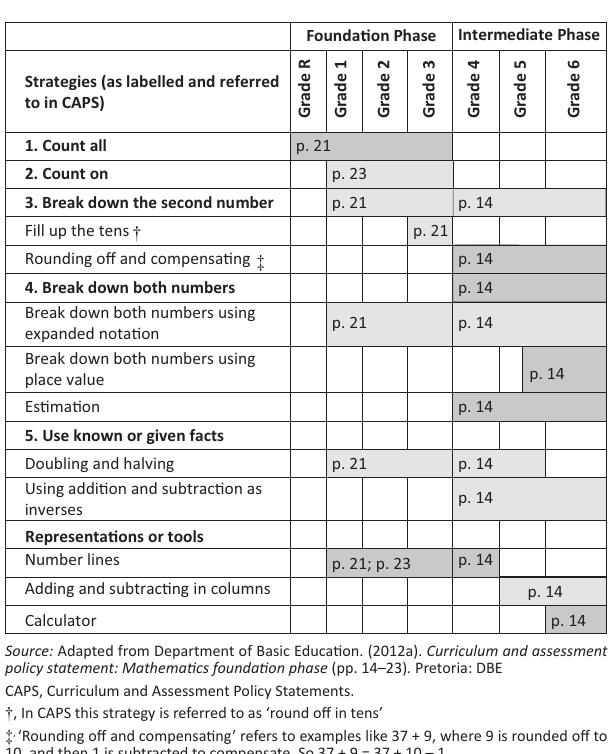
FIGURE 7: Everyday Mathematics variation of the SWA.